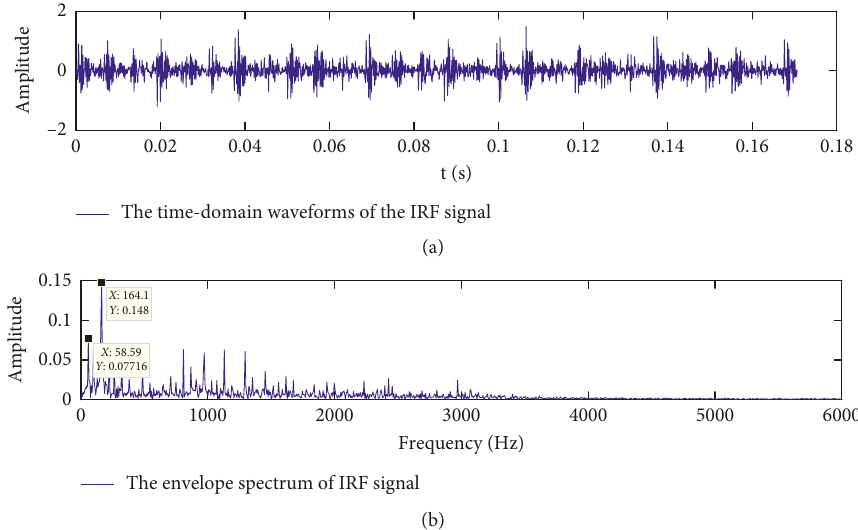
Figure 6: The time domain waveforms and the envelope spectrum of the IRF2 signal: (a) time domain; (b) envelope